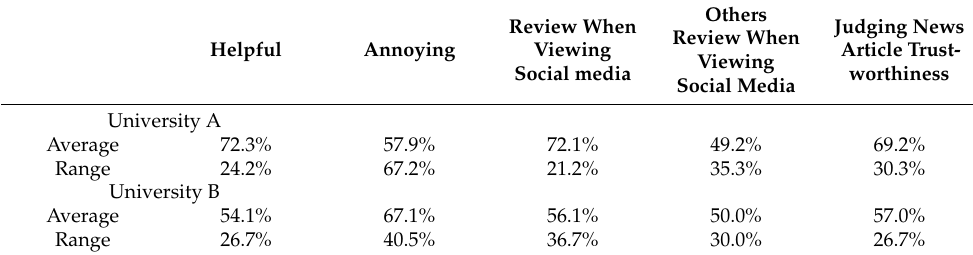
Table 18. Data characteristics—informational and warning label survey by school.